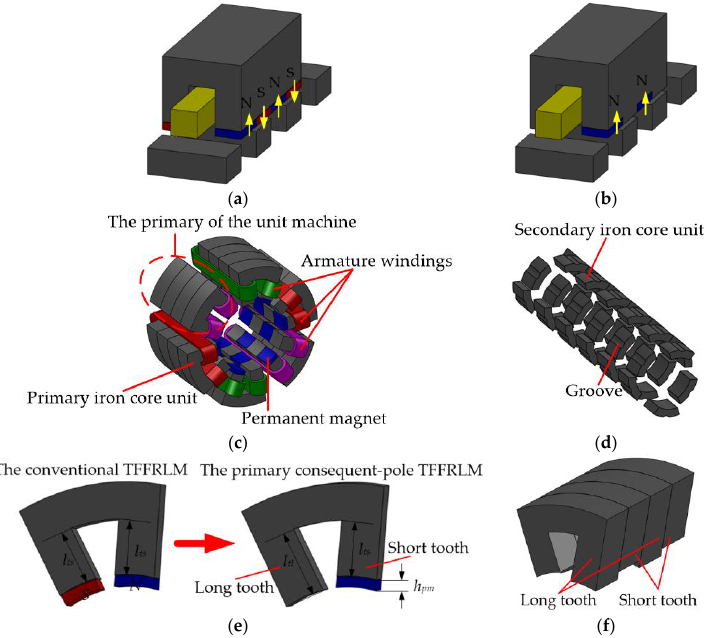
Figure 1. The structure diagram of the TTFFRLM: ( a ) The conventional TFFRLM; ( b ) The primary consequent-pole TFFRLM; ( c ) The primary; ( d ) The secondary; ( e ) The sketch of evolution of primary iron core unit; and, ( f ) The primary iron core of the unit machine.